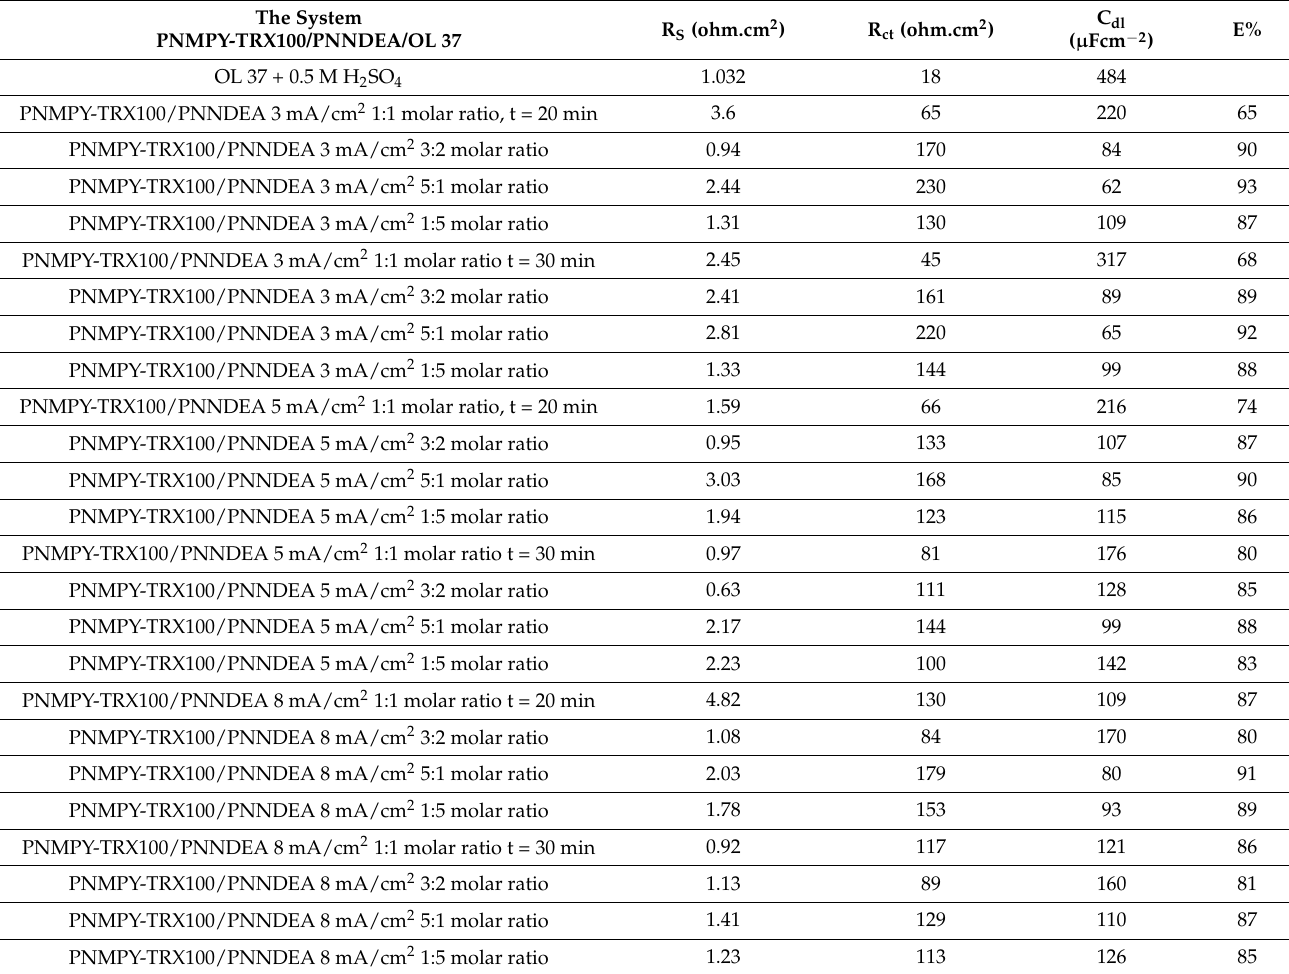
Table 5. EIS Parameters of PNMPY-TRX100/PNNDEA-Coated and -Uncoated of OL37 Electrode in 0.5 M H 2 SO 4 Solutions at 25 ◦ C. The System PNMPY-TRX100/PNNDEA/OL